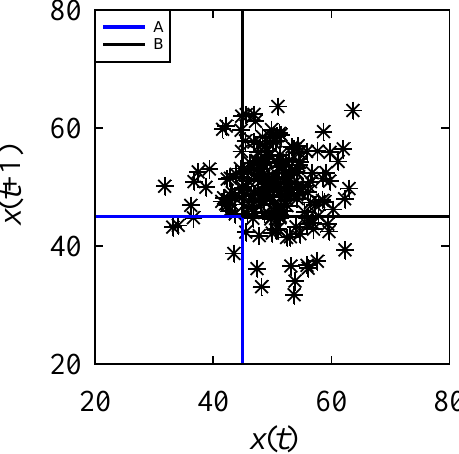
Figure A5. Relative position of A and B in the point-cloud ( x ( t ), x ( t + 1)).